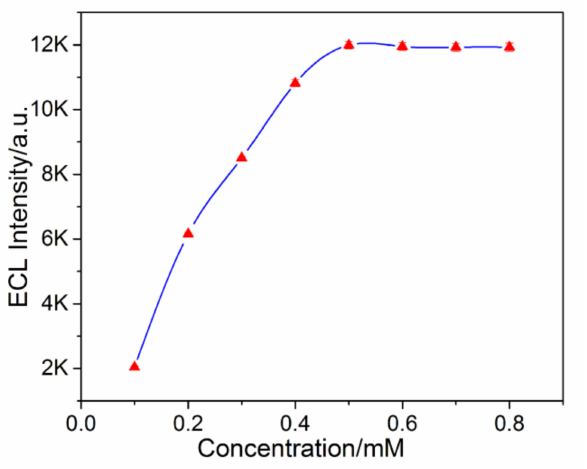
Figure 5. ECL intensity vs. the concentration of Ru(bpy) 32+ . AZA (1.0 mM); PBS (0.1 M; pH 8.5); PMT = 900